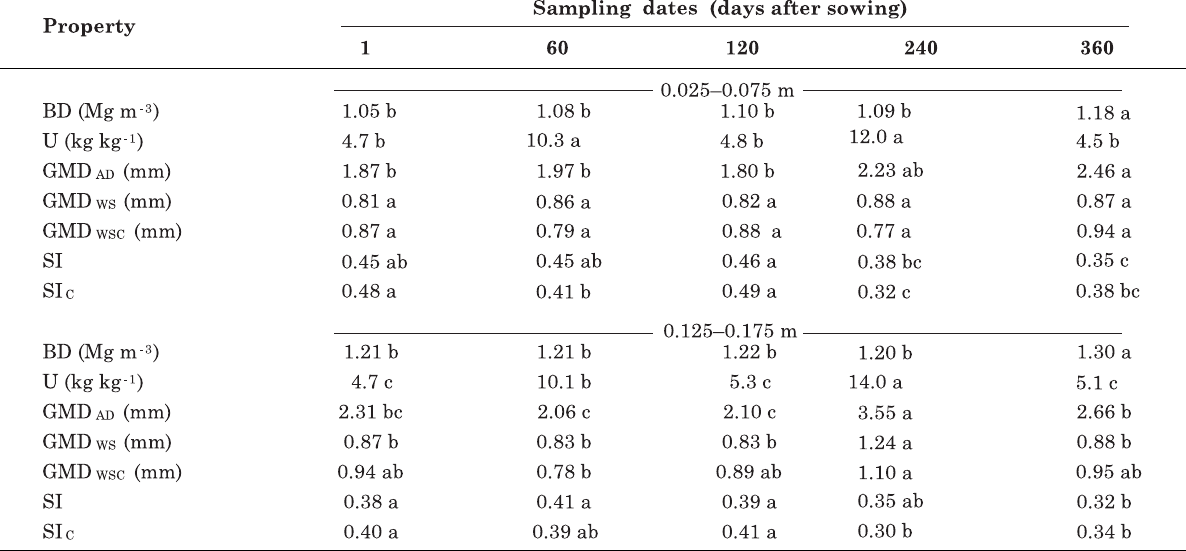
Table 7. Bulk density, gravimetric moisture at time of water aggregate stability test, size distribution and aggregate stability indexes at two layers and in five sampling dates performed during the tenth year (averaged across tillage